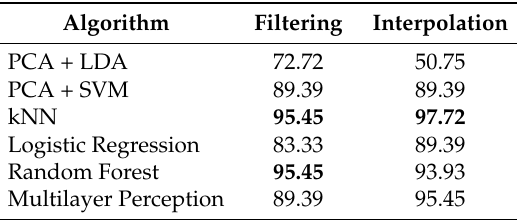
Table 11. Classification accuracies of Empatica E4 when removed inter-beat interval artifacts are replaced with interpolation vs. when they are